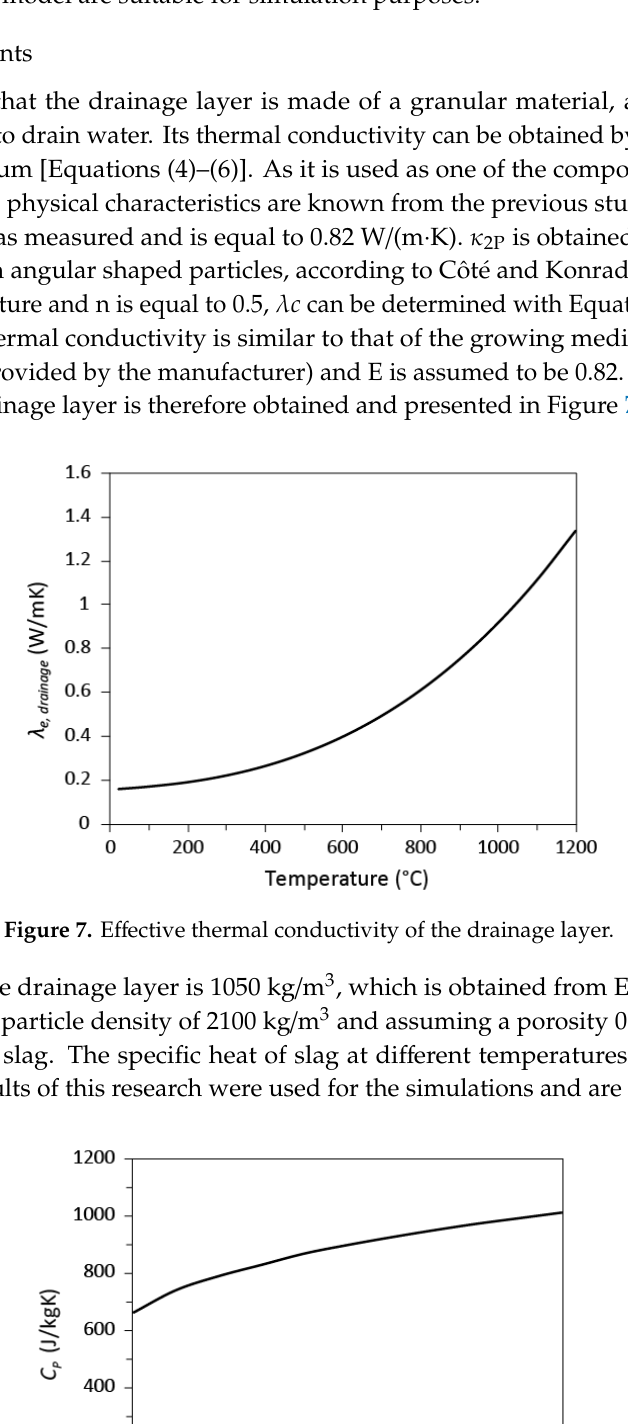
( b ) ( c ) Figure 9. Temperature dependent properties of wood: ( a ) Thermal conductivity; ( b ) specific heat; ( c ) density.